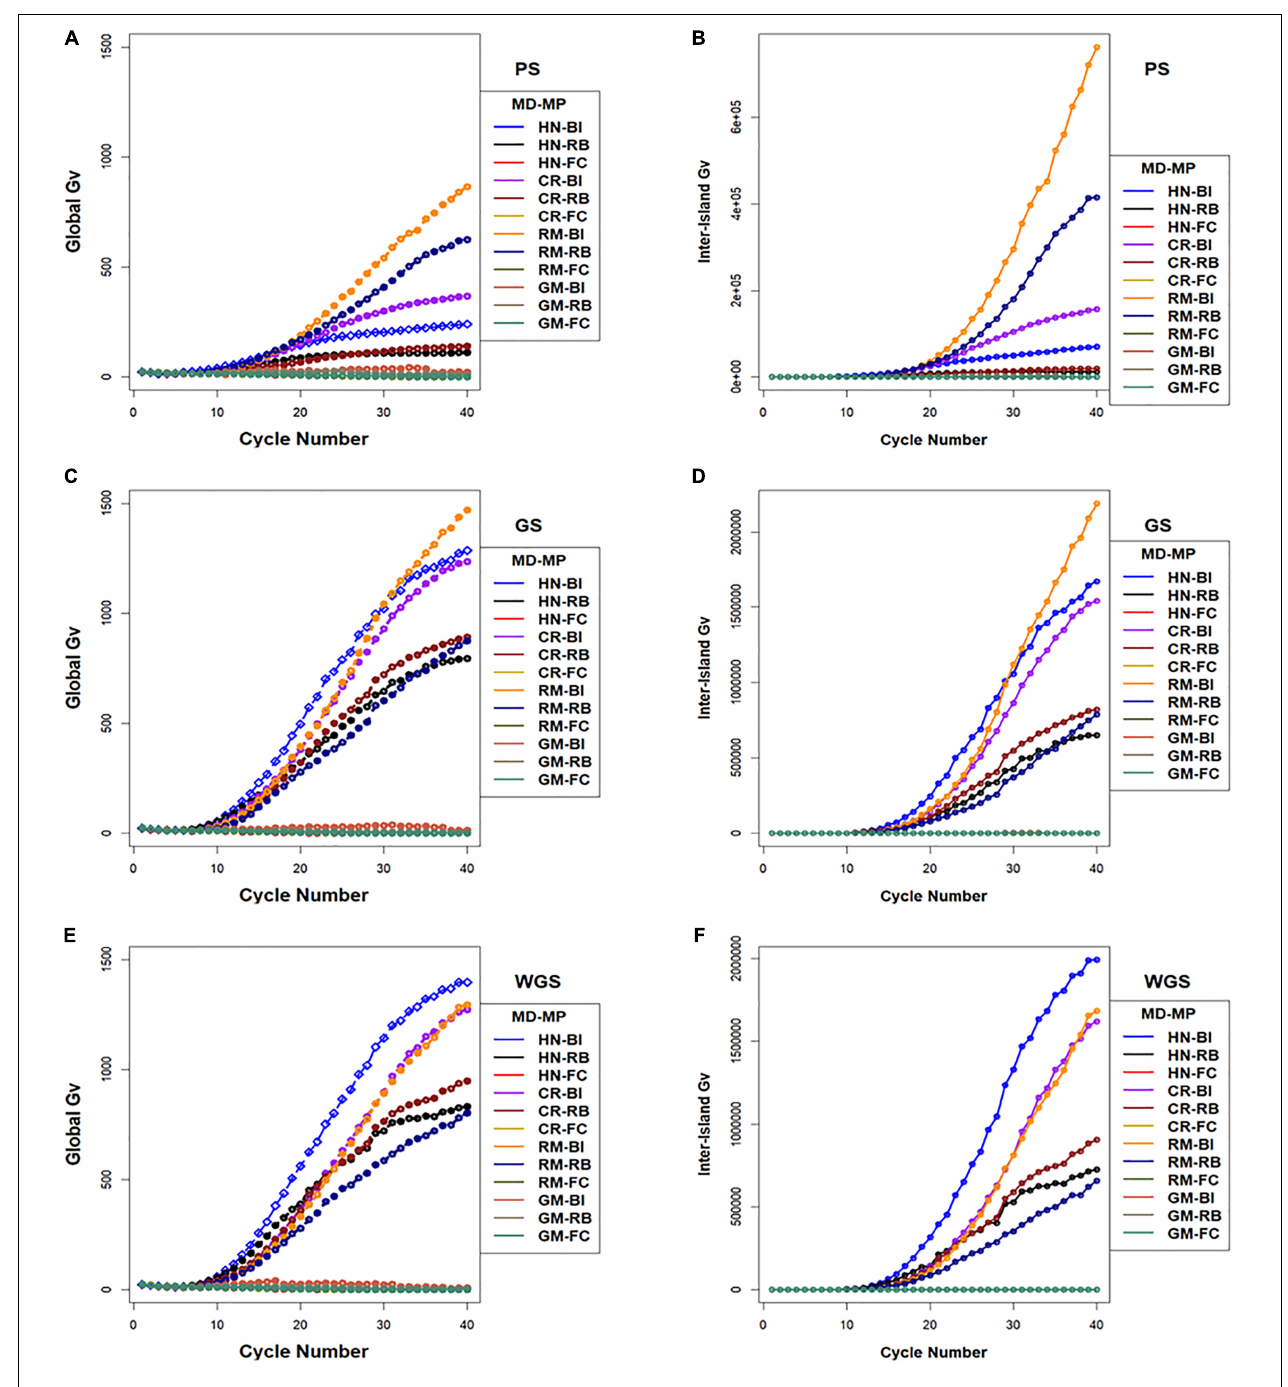
FIGURE 8 | Global and inter-island genotypic variance in island selection. (i) Global genotypic variance (A,C,E) and (ii) Inter-island genetic variance (B,D,F) for Phenotypic Selection (PS) (A,B) , Genomic Selection (GS) (C,D) , and Weighted Genomic Selection (WGS) (E,F) for the four mating designs including Hub Network (HN), Chain Rule (CR), Random Mating (RM), and Genomic Mating (GM) methods. Migration policy included “Best Island” (BI), “Random Best” (RB), and “Fully Connected” (FC) for 400 simulated QTL and 0.7 H. Migration rules included bidirectional exchange of two immigrants and emigrants every other cycle of selection. Genotypic variance is standardized to the average genotypic variance in founder populations in cycle “0.” GP models are updated every cycle in GS and WGS using training sets with data from all prior cycles of selection.